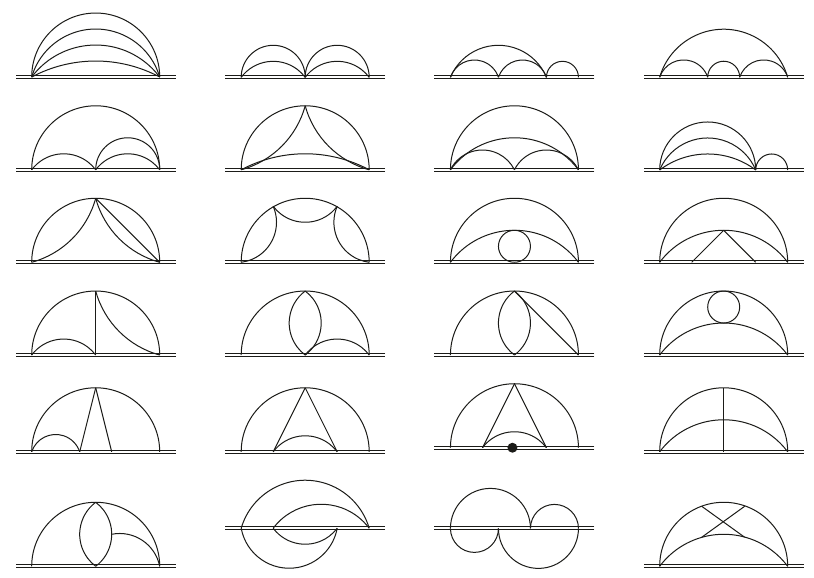
Figure 4 . Non-planar master integrals needed for the computation. The double line represents an HQET